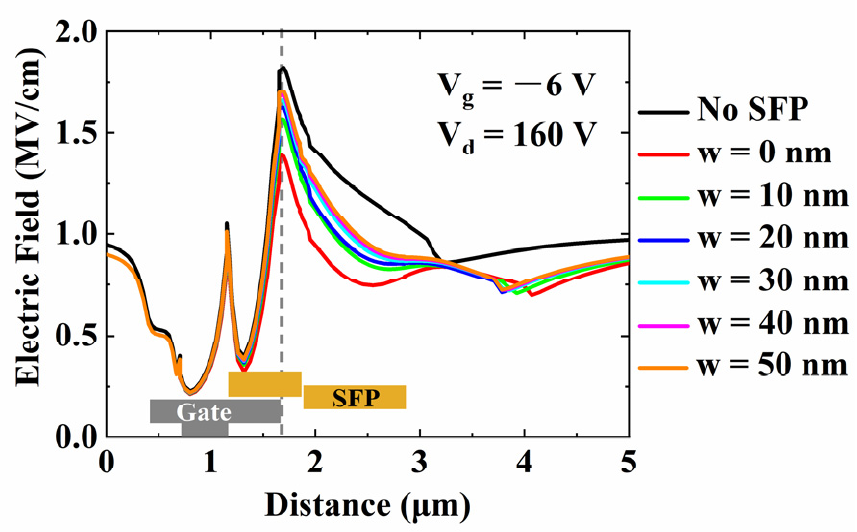
Figure 6. Electric field along the channel for various AlGaN/GaN HEMTs.